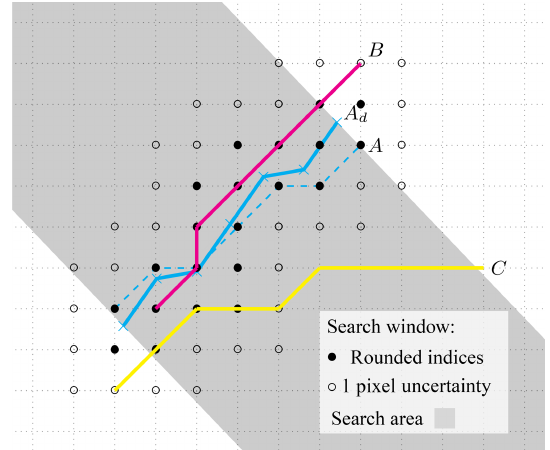
Figure 7. Principle of the tracking algorithm showing the search area and search window. A is the original feature (dashed blue) and A d (blue) the first-guess position considering only drift. B and C are two features in the second record, in which B is marked as a successfully tracked